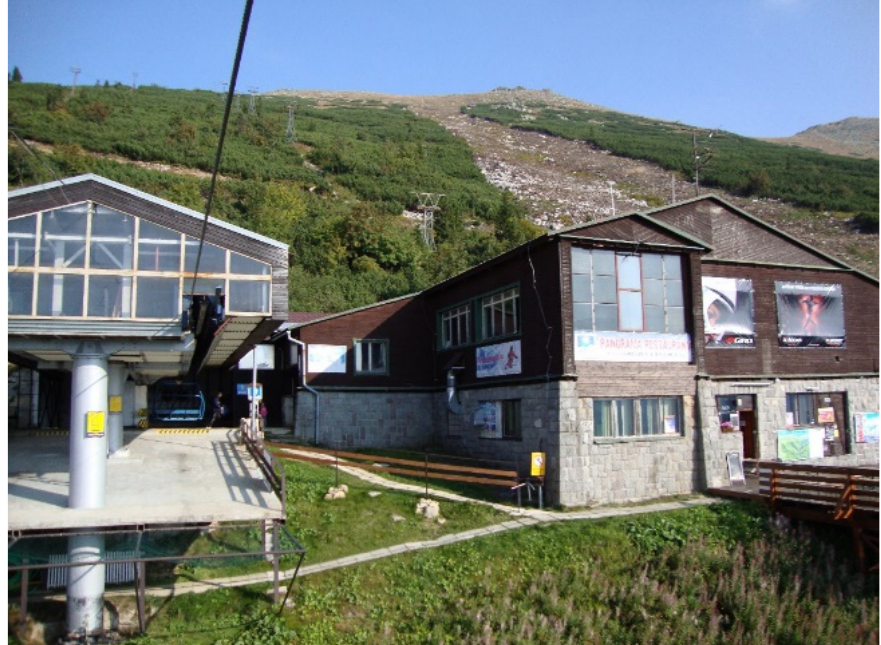
Figure 9. Tourism superstructure on the southern slope of the Chopok massif (2023 m a. s. l.), dividing the chamois habitat into two parts (photo B. Gregorová) .